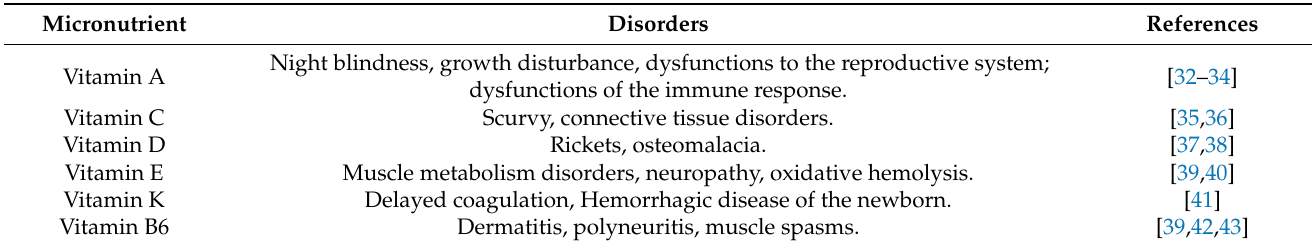
Table 2. Vitamin deficiency disorders in humans. Micronutrient